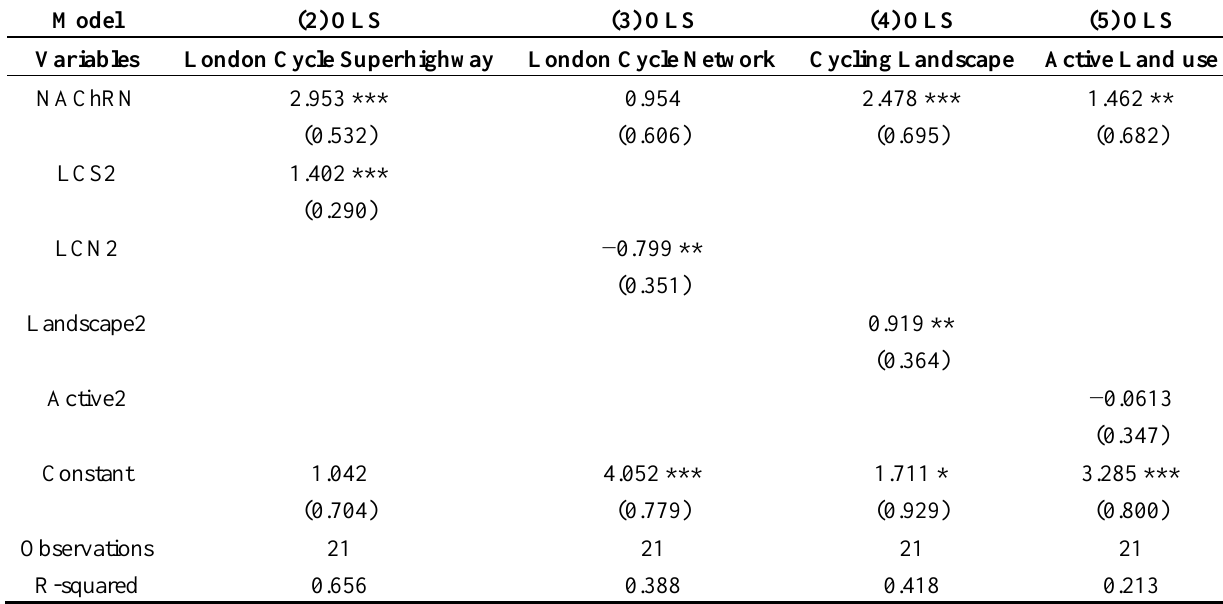
Table 6. Cyclist movement model stepwise regression